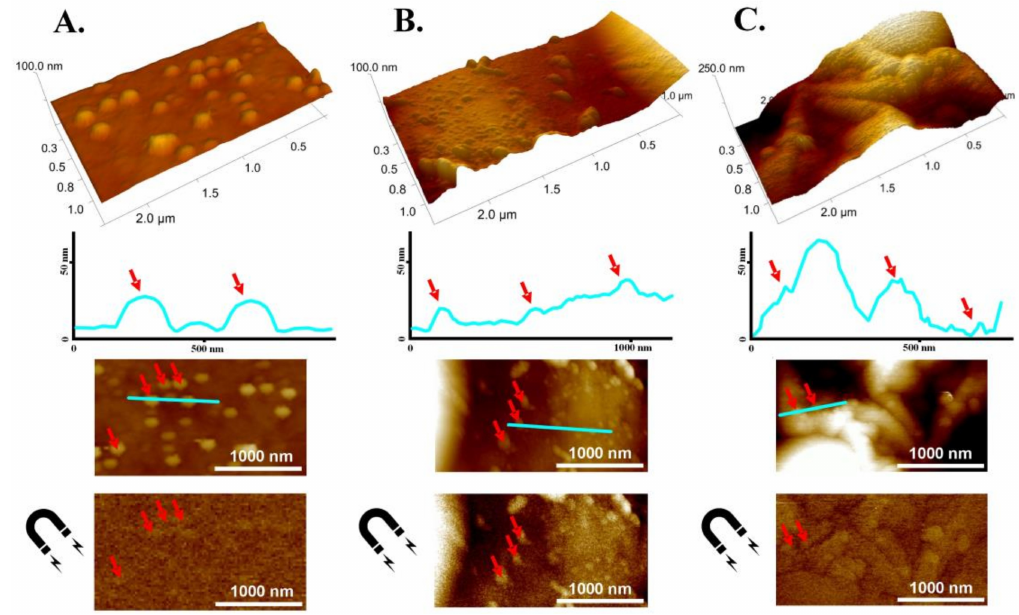
Figure 7. AFM topography and magnetic phase images for Fe-CMC ( A ), Co-CMC ( B ), and Ni-CMC ( C ). An arrows indicates magnetic